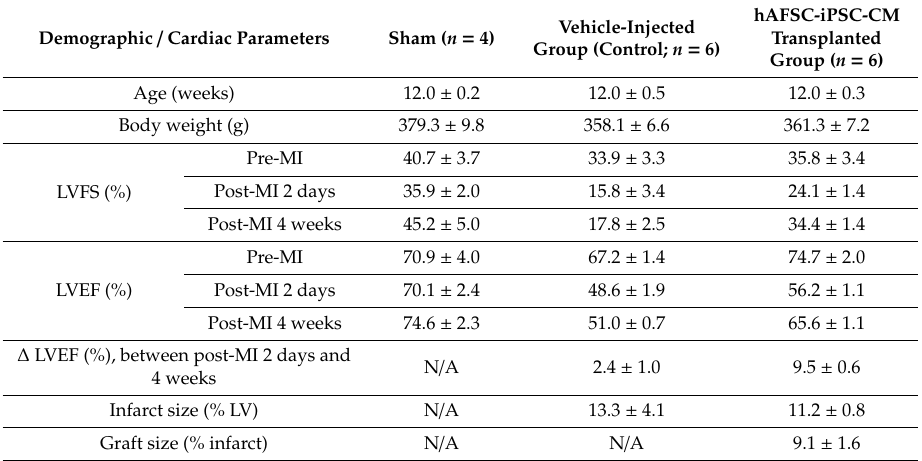
Table 1. Characteristics of morphometry and left ventricular